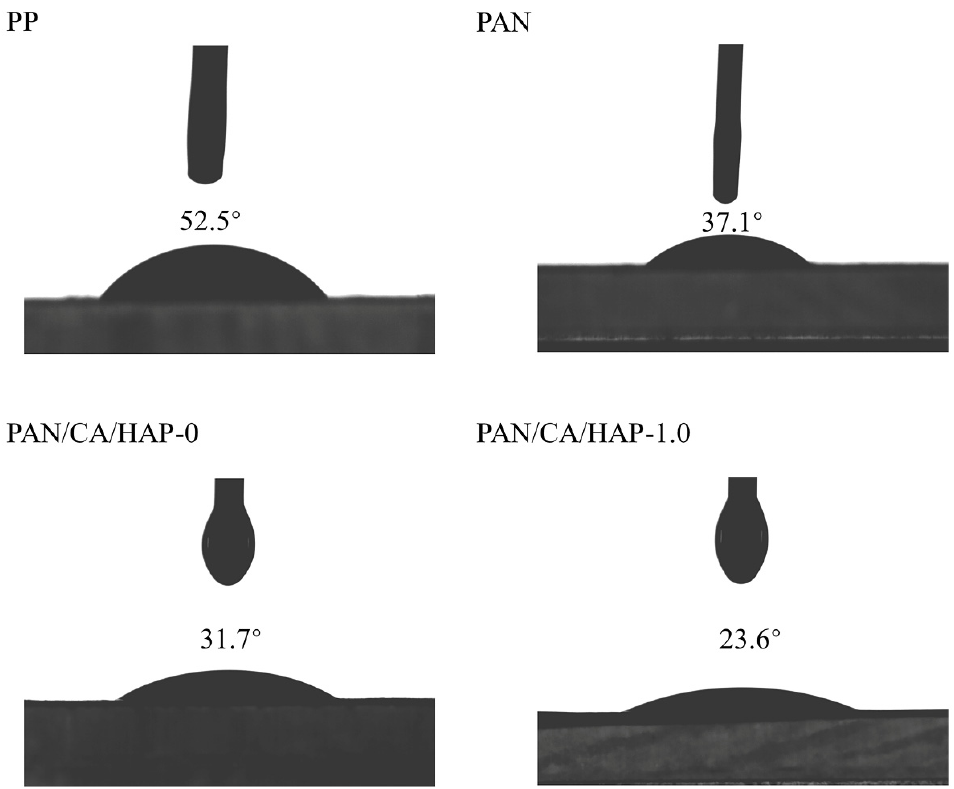
Figure 8. Contact angle test of PP, PAN, PAN/CA/HAP-0 and PAN/CA/HAP-1.0 separators with electrolyte.